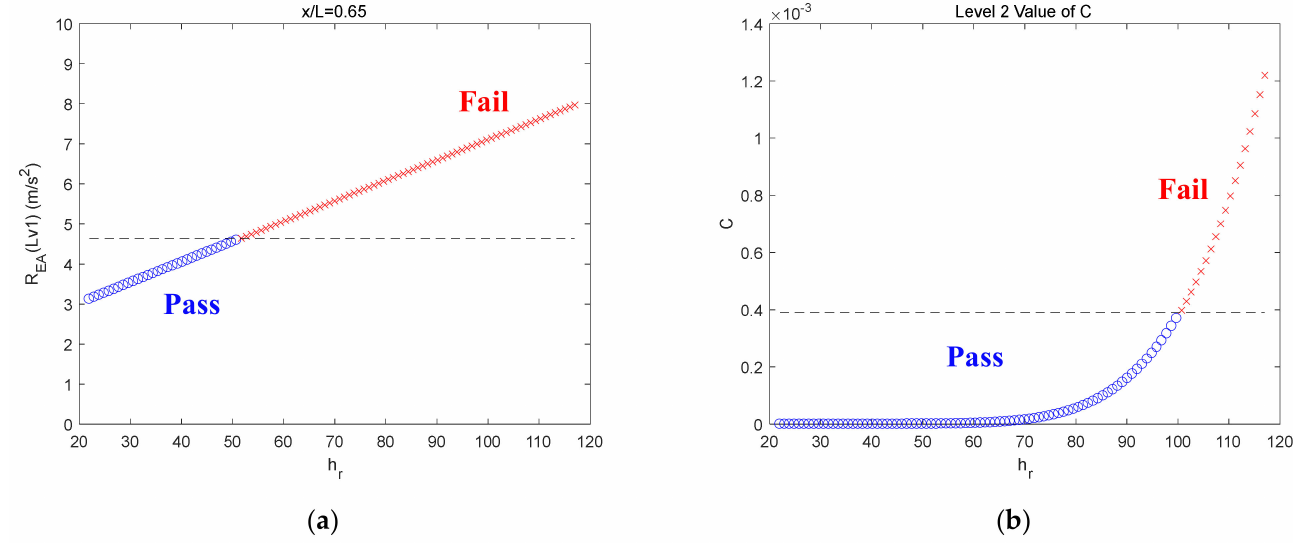
Figure 6. The vulnerability criteria assessment for excessive acceleration mode of the 13 K oil chemical tanker. ( a ) Lv1 criterion